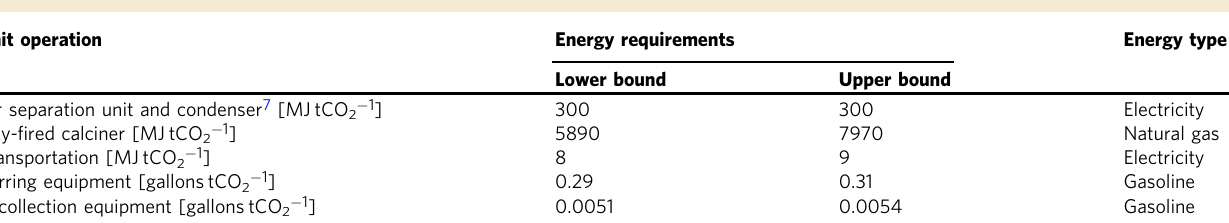
Table 3 Energy requirements for the MgO looping